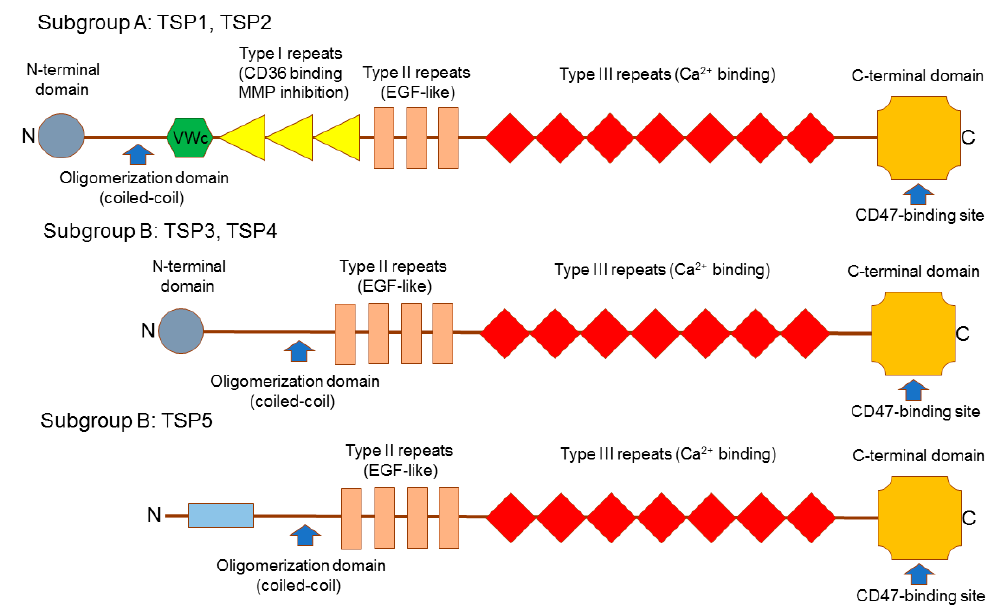
Figure 1. Structure of thrombospondins (TPSs). TSP family includes five members: TSP1–5. Subgroup A comprises TSP1 and TSP2 that form pentamers while subgroup B contains trimeric TSP3–5. TSPs have a complex multidomain architecture that provides an option to bind various ligands. For example, C-terminal domain contains CD47-binding site. Type III repeats are involved in Ca 2+ binding while Type I repeats are responsible for the interaction with CD36, a receptor for TSP1 and TSP2, and inhibition of matrix proteinases (MMPs). Type II EGF-like domains are involved in the regulation of various signaling pathways such Notch and others. C -terminal domain, Type III repeats and Type II epidermal growth factor (EGF)-like repeats share high homology in all TSPs and represent a signature of the TSP family. Von Willebrand factor type C (VWc) domain is cysteine-rich and is implicated in binding members of the transforming growth factor- β (TGF- β ) superfamily. The oligomerization (coiled-coil) domain drives formation of TSH homooligomers. The N-terminal domain, which is present in TSP1–4 and absent in TSP5, is less conservative. This domain regulates structure and stability of the coiled-coil region and binds heparin.